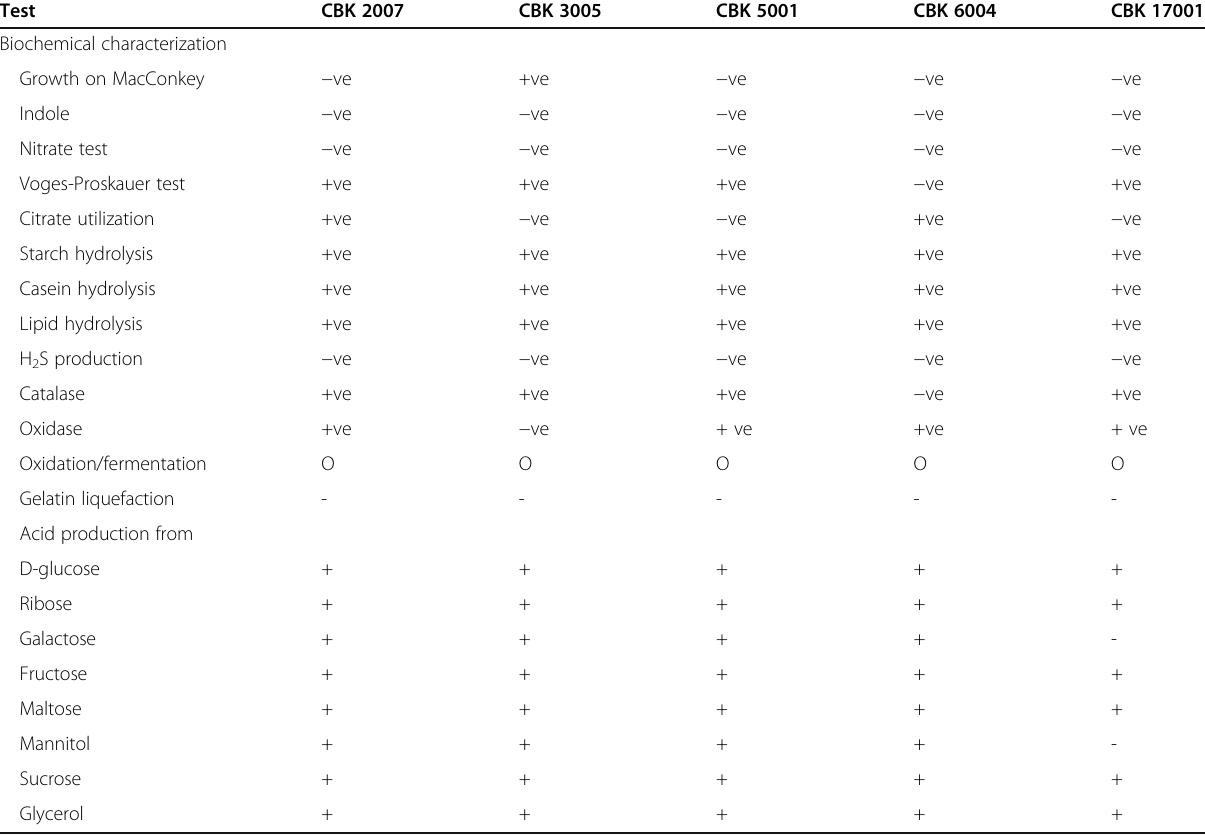
Table 3 Biochemical characteristics of strain CBK2007, CBK3005, CBK5001, CBK6004, and CBK17001